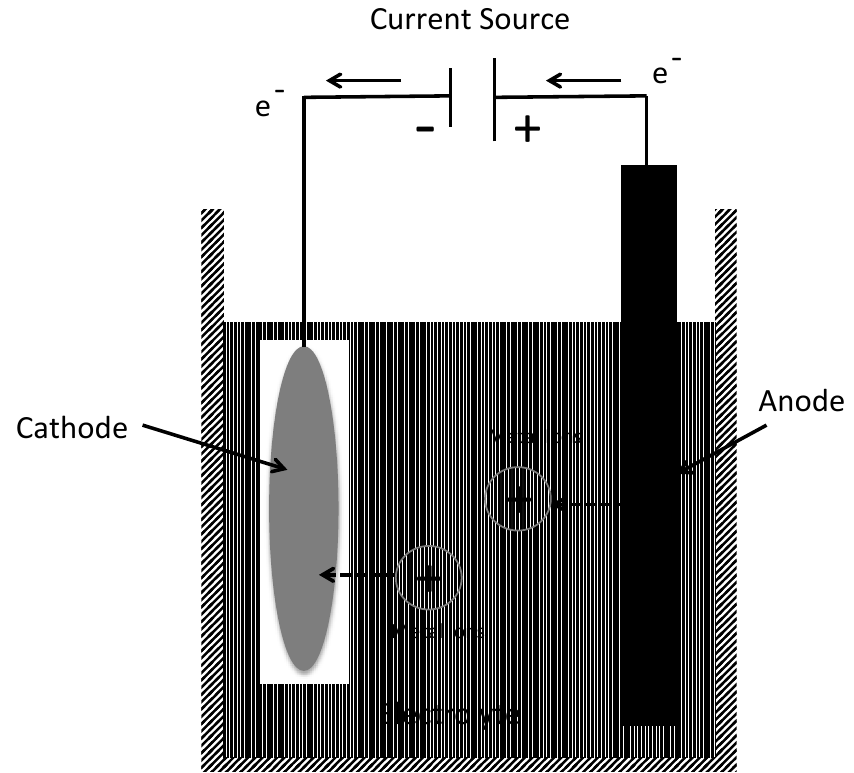
Figure A7. Setup for electroplating of metals onto substrates.